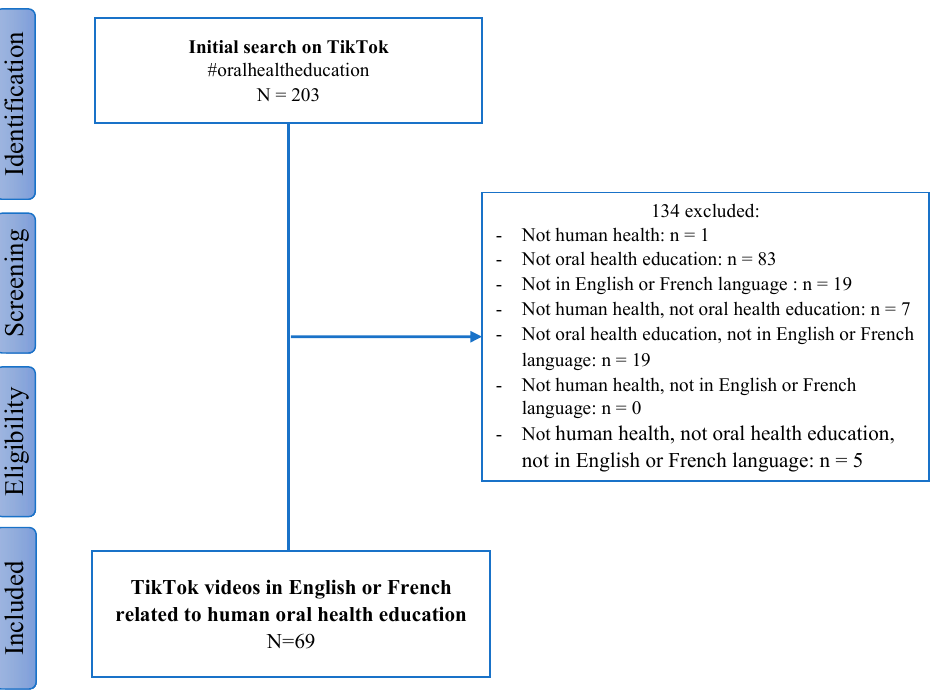
Figure 1. Chart flow of the TikTok videos corresponding to #oralhealtheducation.